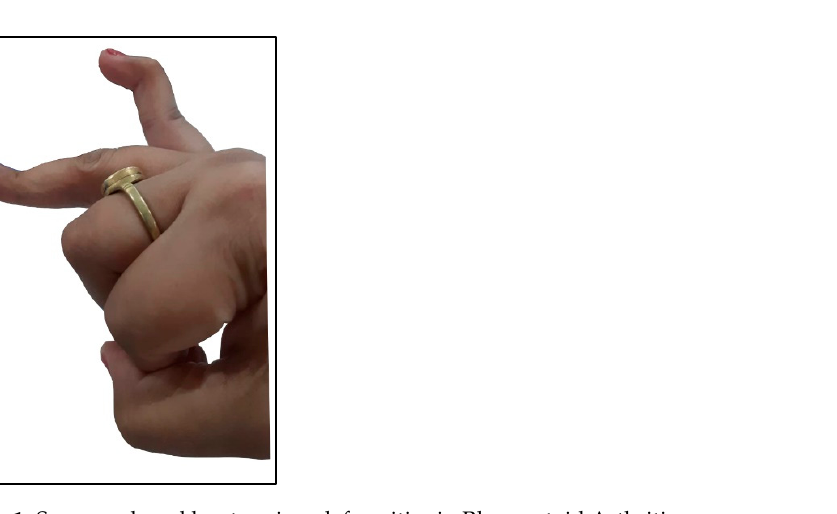
Figure 1. Swan neck and boutonniere deformities in Rheumatoid Arthritis .